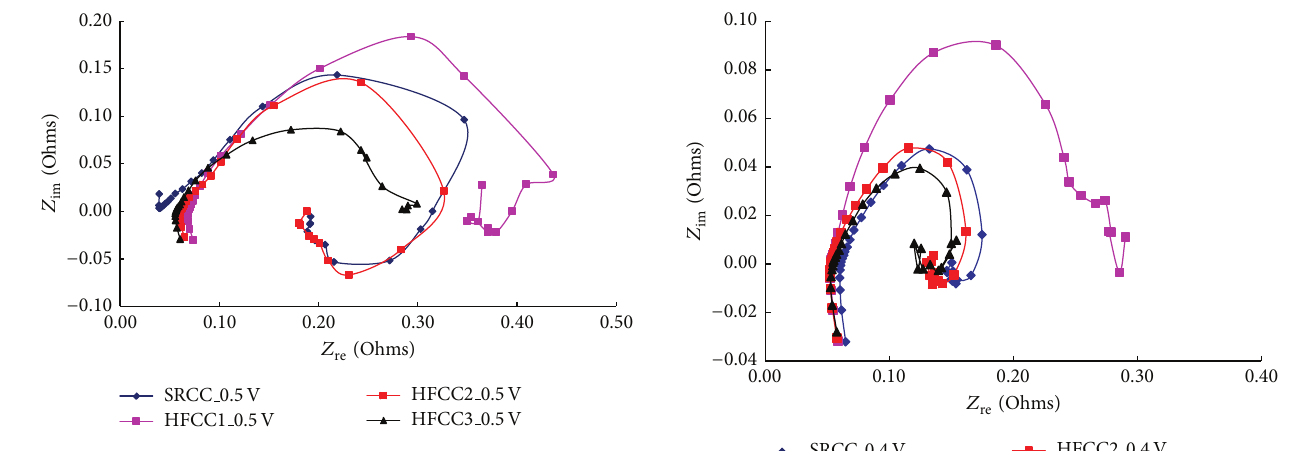
Figure 6: Comparison of the Nyquist plots at 0.5 V for the DMFC with different current collectors.